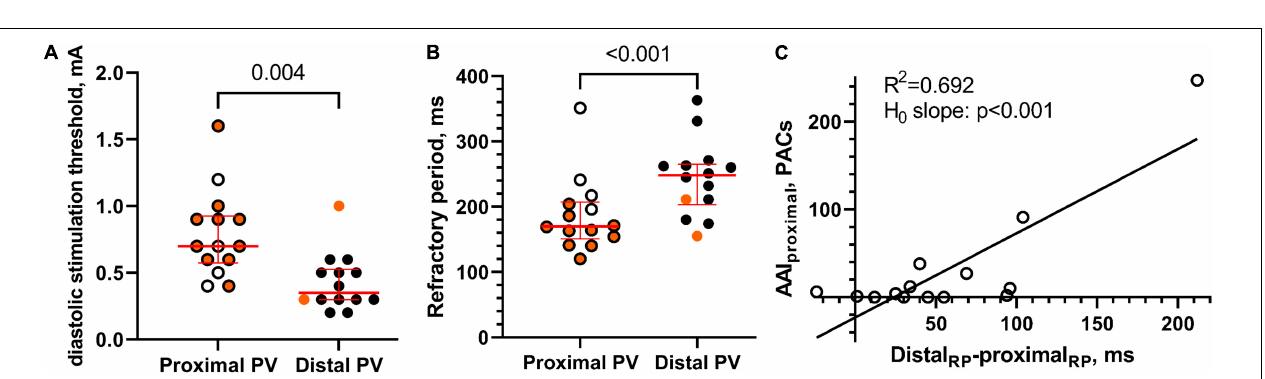
FIGURE 6 | Inducibility of atrial arrhythmias. (A) The atrial arrhythmia inducibility was calculated as the sum of PAC during the last five premature S2 decrements of the programmed stimulation protocol causing local activation and before reaching the refractory period ( n = 14 in the proximal and distal PVs). (B) The number of PAC as a function of the difference between the S1-S2 coupling interval and the refractory period. More PAC were induced when the S1-S2 coupling interval approached the refractory period. Note the few PAC during the distal PV pacing (represented in gray color).